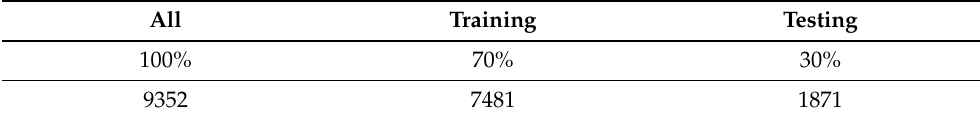
Table 3. The details of training and testing of the